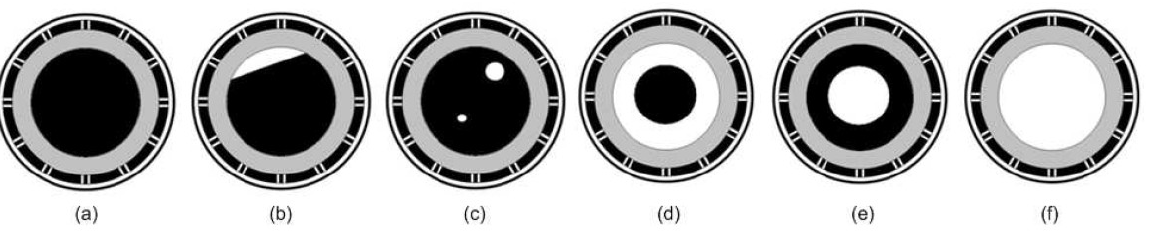
Figure 3. A schematic diagram of ( a ) full ( b ) stratified ( c ) bubble ( d ) core ( e ) annular and ( f ) empty flow